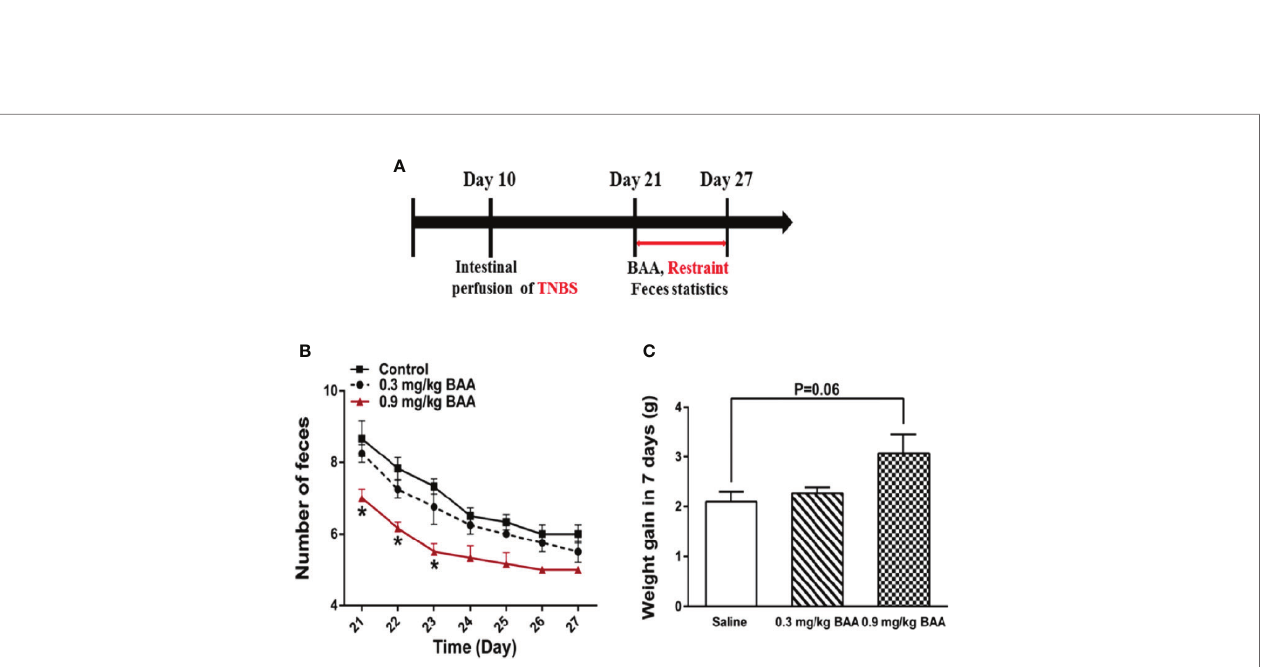
FIGURE 7 | The effects of Bulleyaconitine A (BAA) on the amount of feces and weight gain during puberty in rats with chronic visceral pain. (A) Timeline of experimental protocols to induce chronic visceral pain in rats. (B) The effect of BAA on the number of bowel movements in rats after 2 h of restraint stress every day (n=6 each; one-way ANOVA; * P < 0.05 0.9 mg/kg BAA vs. Control). (C) The effect of BAA on the weight gain of rats during the experiment (n = 6 each; one-way ANOVA). The data are presented as means ± standard error of means